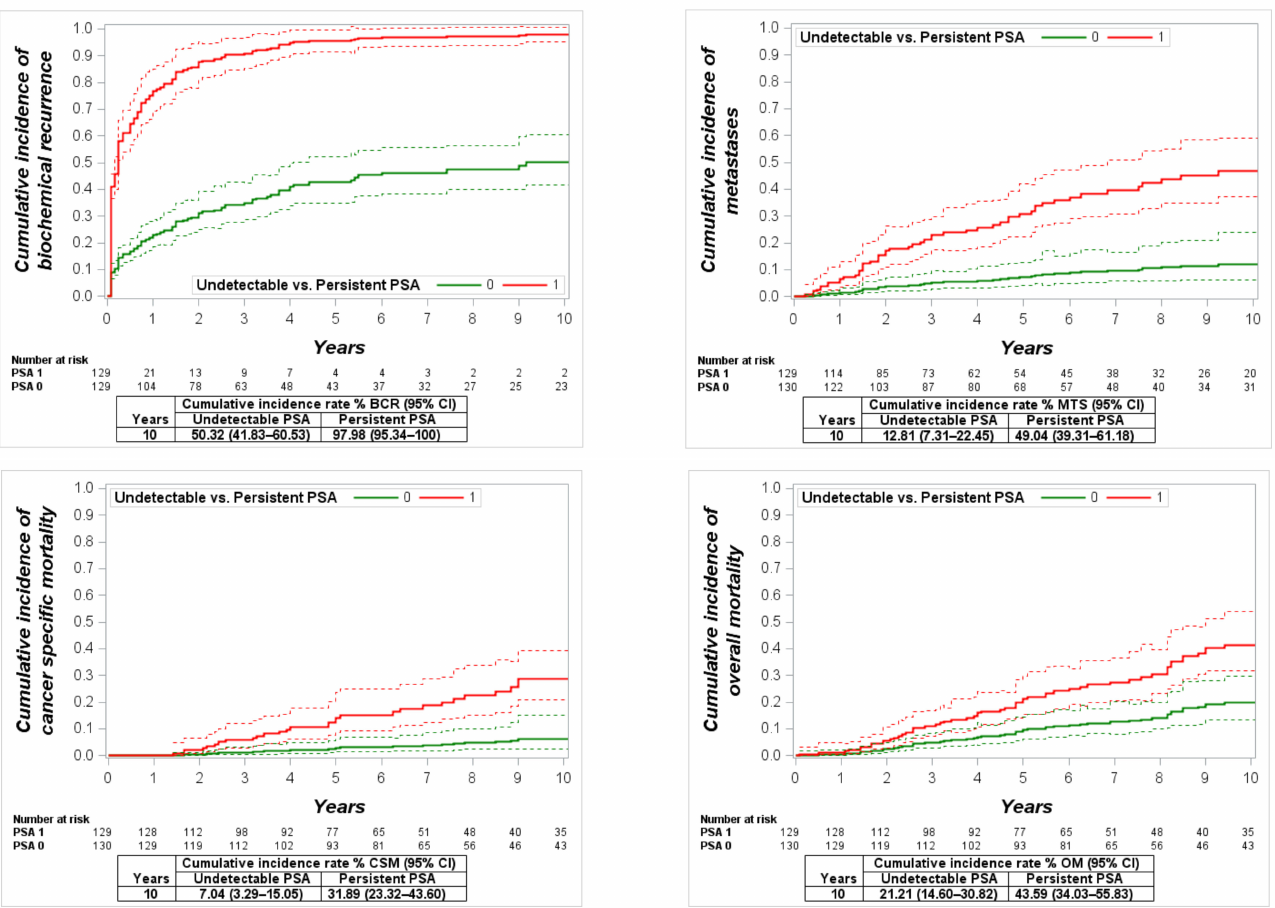
Figure 5. Cumulative incidence function for biochemical recurrence (BCR), metastases (MTS), cancer-specific mortality (CSM) and overall mortality (OM) in high-risk patients with undetectable vs. persistent prostate-specific antigen